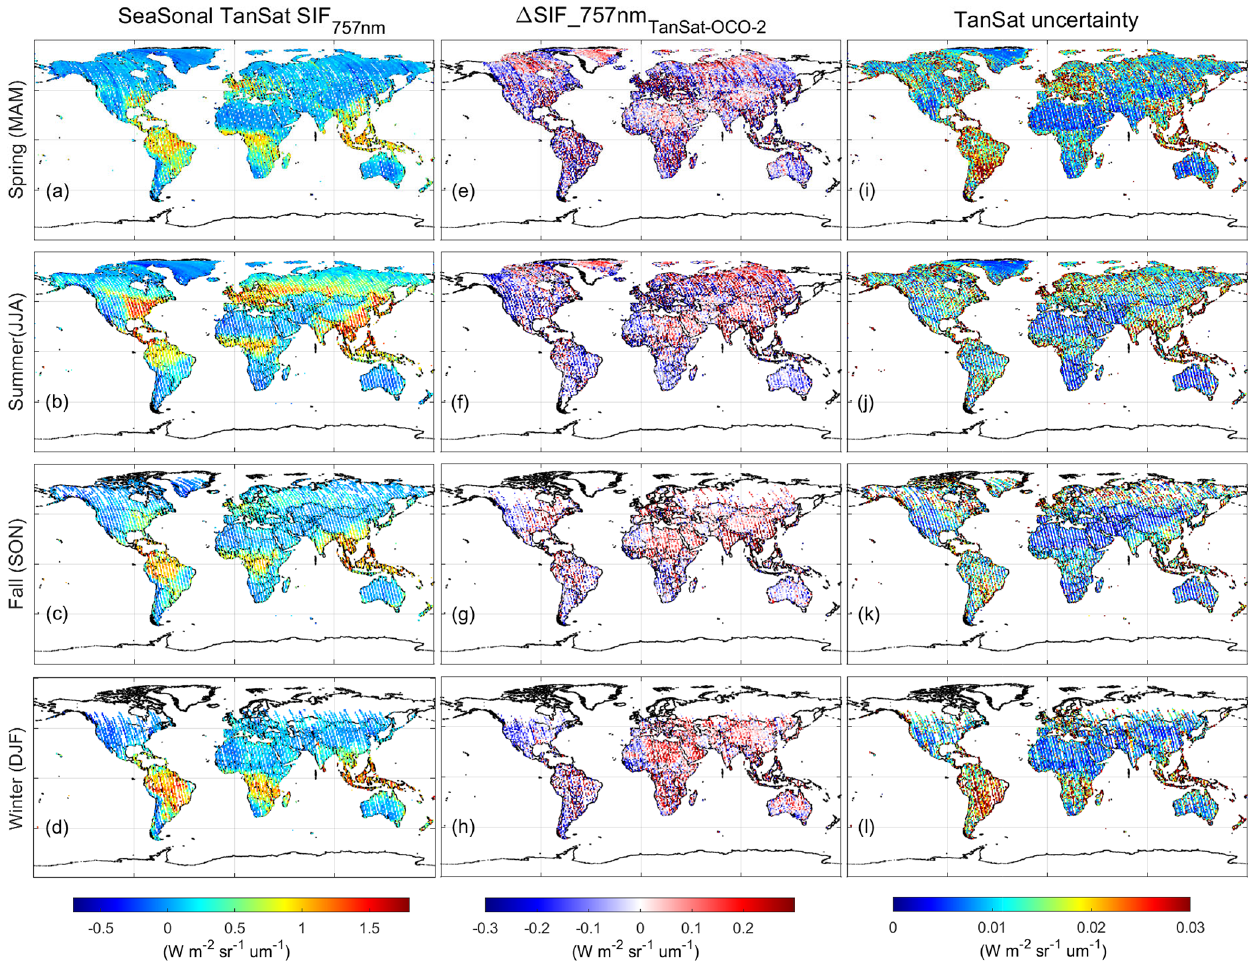
Figure 4. Global TanSat SIF (left, a–d ), differences between TanSat and IAPCAS OCO-2 SIF values (middle, e–h ), and the grid-cell retrieval uncertainty estimated from TanSat (right, i–l ) at 1 ◦ × 1 ◦ spatial resolution. The maps in each row represent a Northern Hemisphere